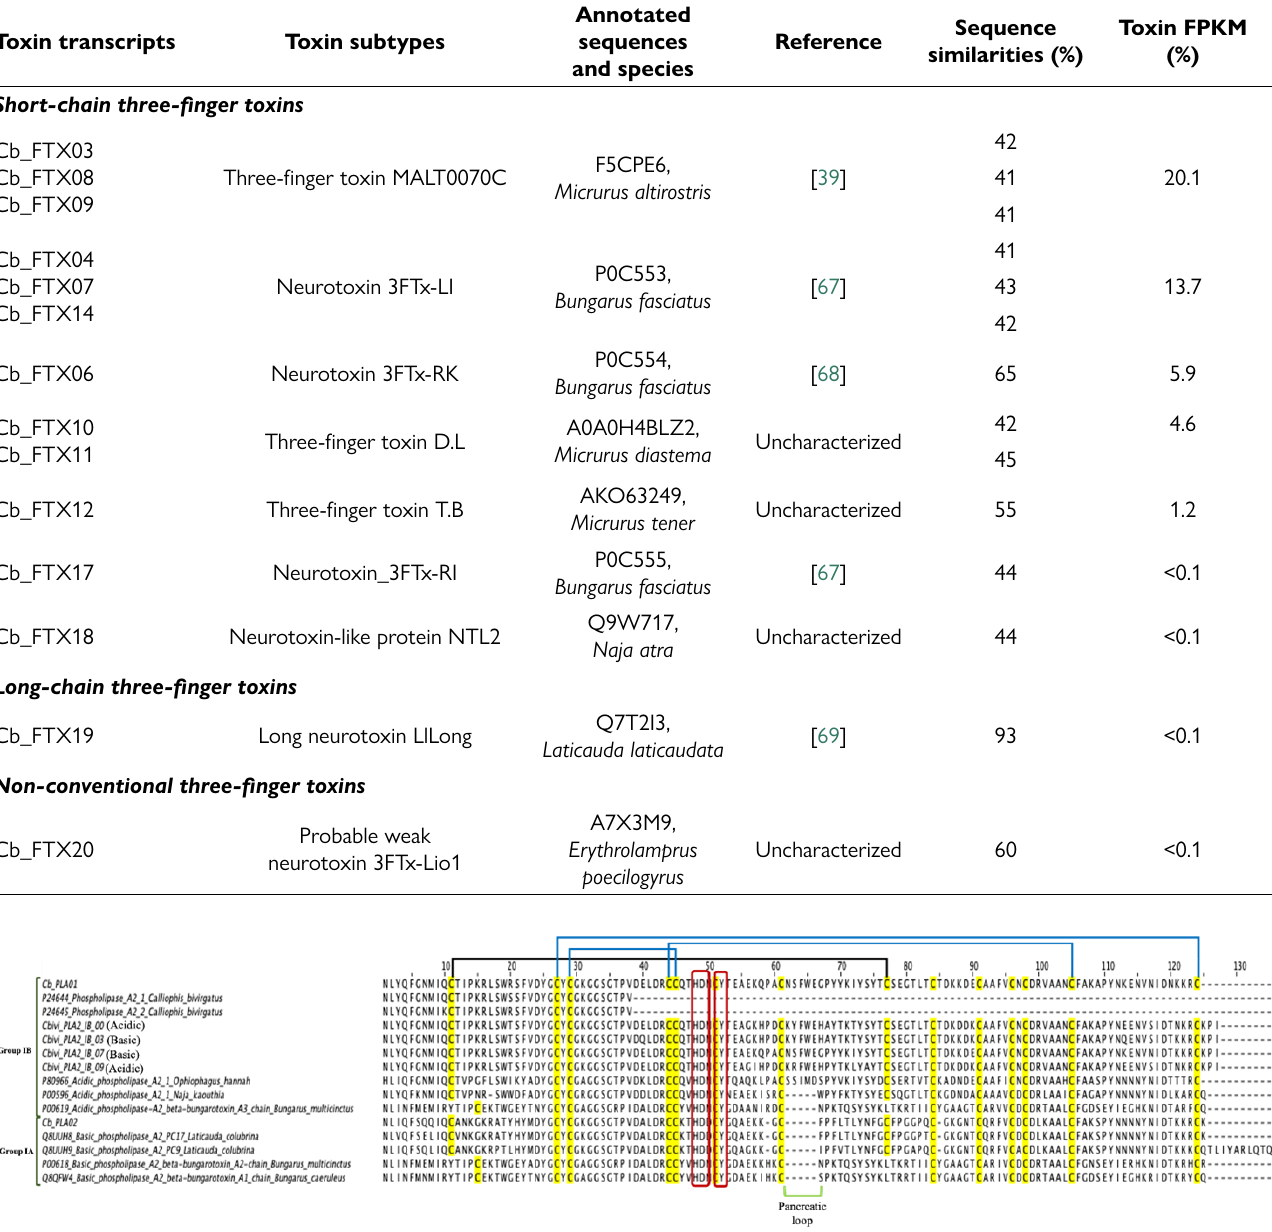
(svPLA ) transcripts (Cb_PLA01 and Cb_PLA02) of Calliophis bivirgata flaviceps aligned 2 2